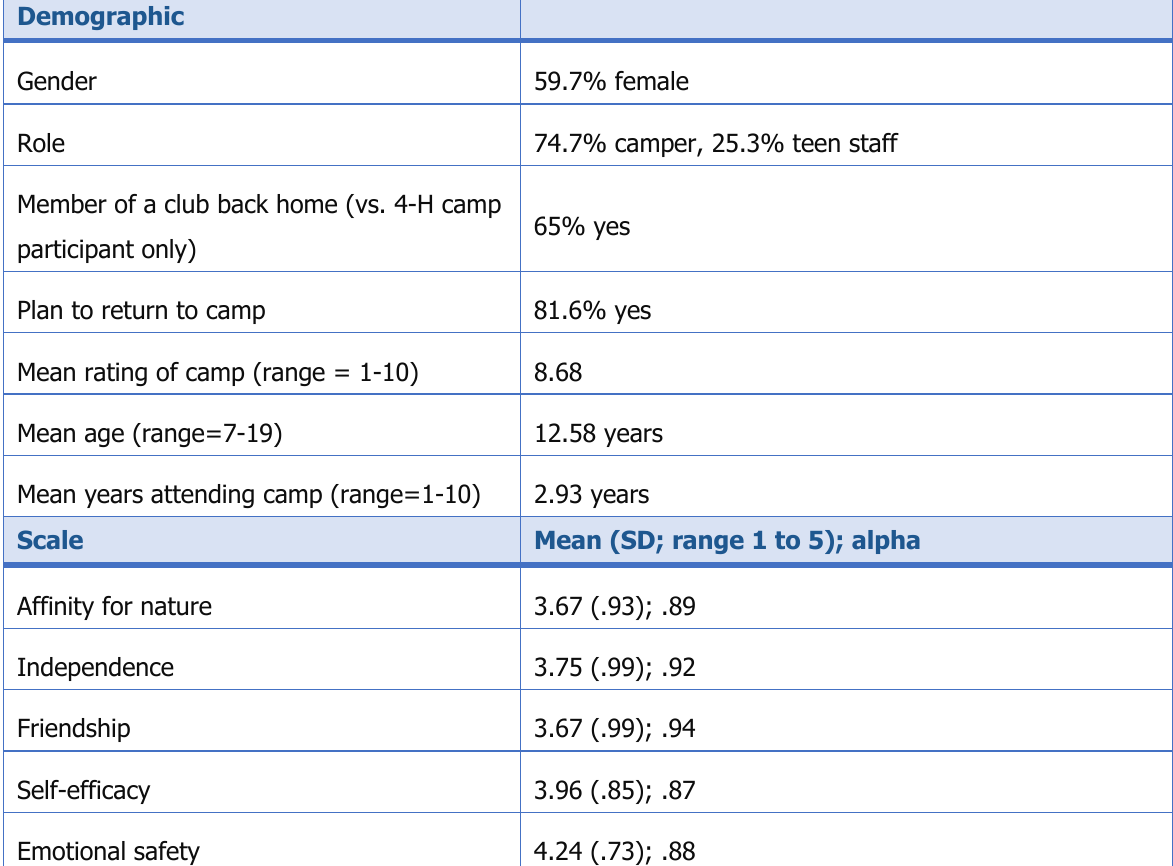
Table 4. Demographics and Descriptive Statistics for Youth Who Completed the Camp Survey in Summer